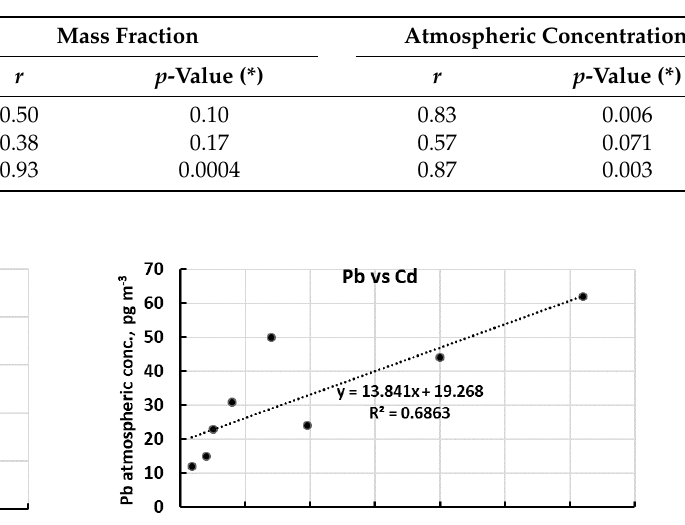
Table 3. Correlation coefficients (r) and significance ( p -value) between metal contents expressed in both measurement units (mass fraction and atmospheric concentration) for the whole series of samples. One-tailed t -test is used since the interest is for r > 0.